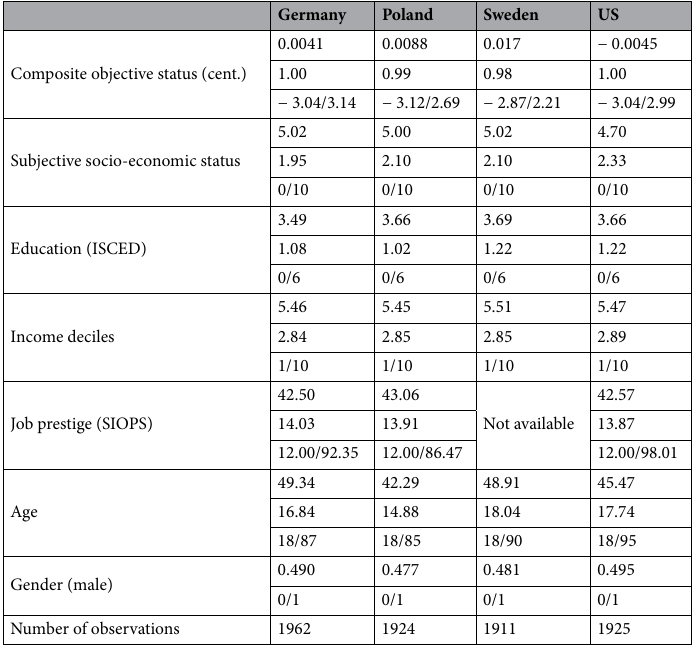
Table 1. Descriptives of sample and status variables (mean, standard deviation, minimum/maximum). No standard deviation is given for binary